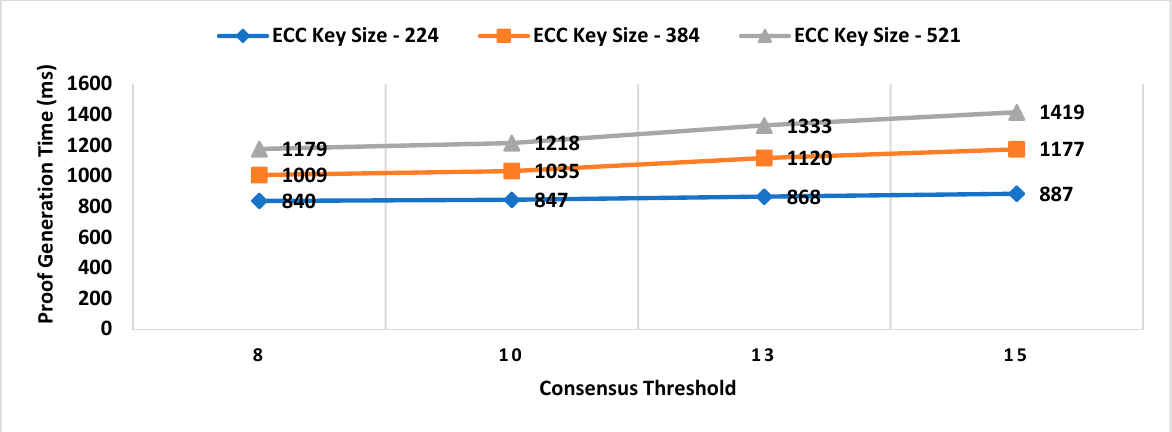
Figure 8. Consensus threshold and key size impact on proof generation time.